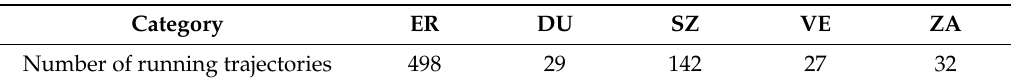
Table 2. Number of running